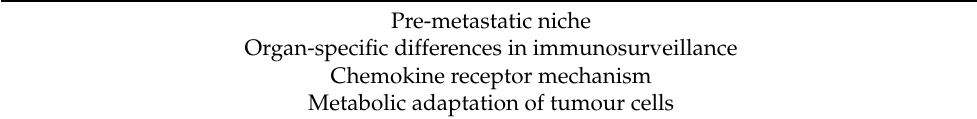
Table 4. Mechanism leading to organotropism in metastases